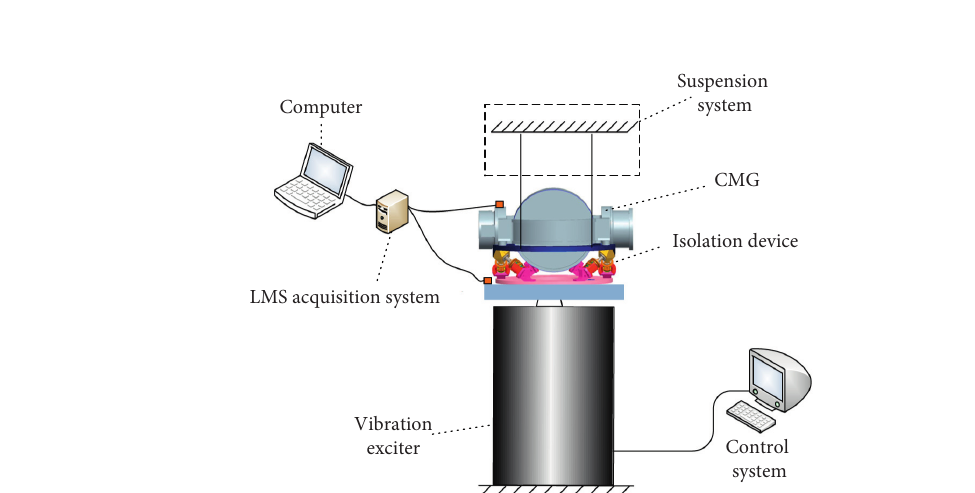
Figure 11: Experimental test